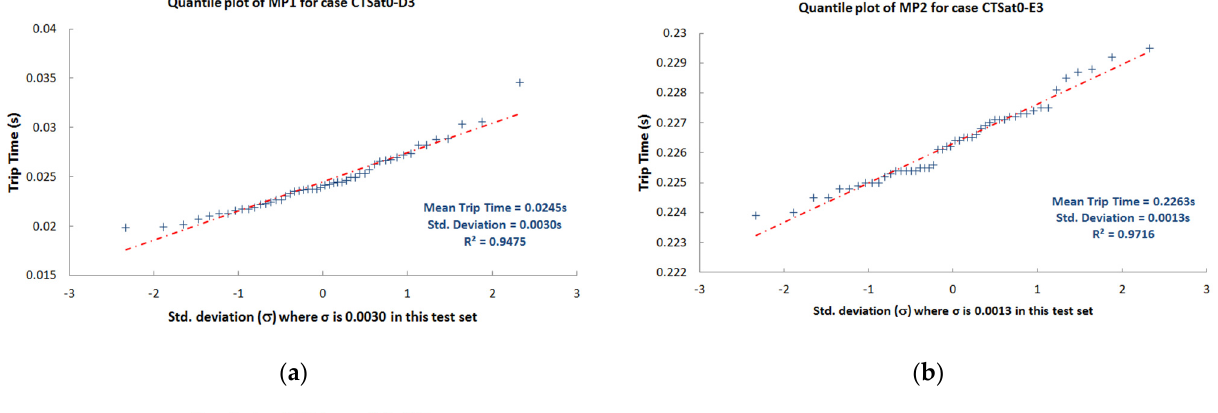
Table 11. Trip times for line-to-line fault.